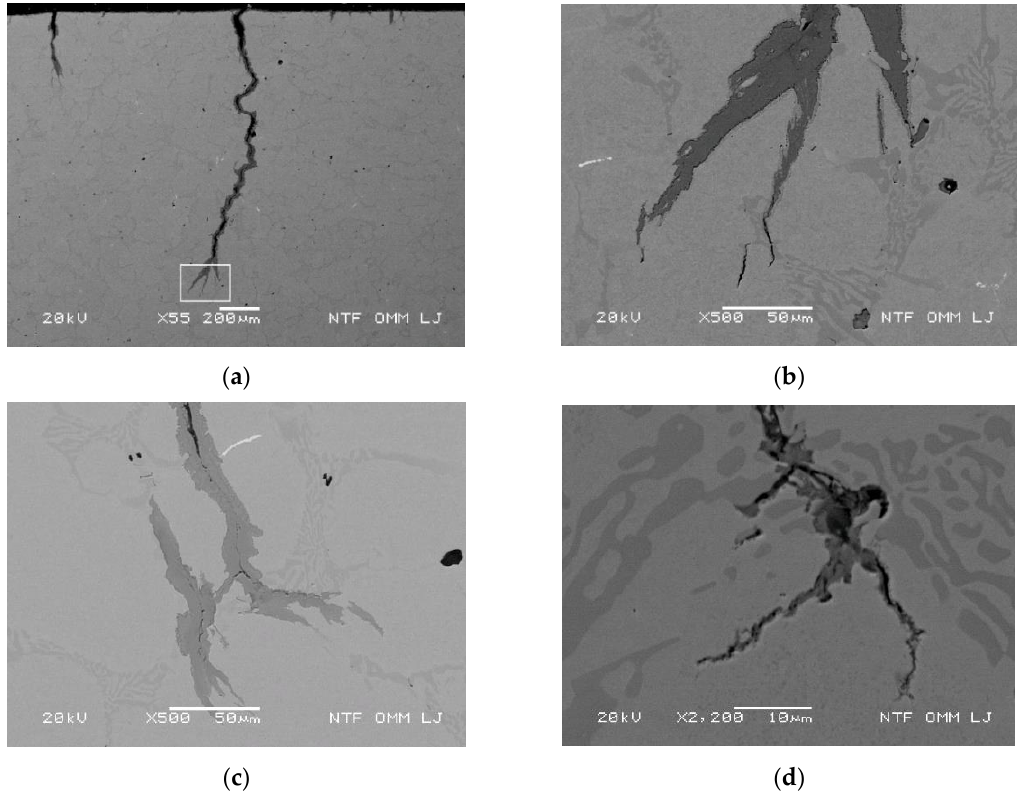
Figure 13. Influence of oxidation on crack branching: ( a ) crack exceeding 1300 μm with marked area of subfigure b, ( b ) primary crack branching and individual approaches of oxide branches to internal cracks, ( c ) branching of the primary crack by oxidation based on low thermal stresses and growth in area with depleted Cr content and ( d ) branching of the primary crack in the preferred oxidation direction and growth towards areas with depleted Cr content in a narrow band adjacent to the eutectic.